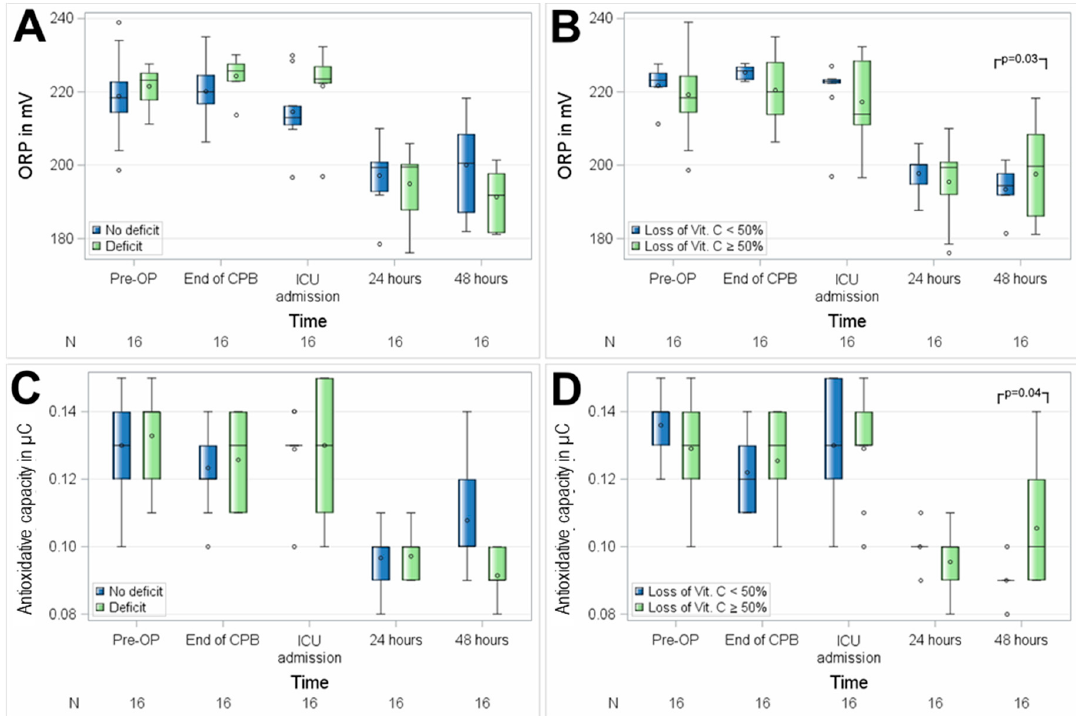
Figure 6. Association of perioperative vitamin C levels with oxidative stress, assessed as oxidation–reduction potential (ORP) ( A , B ) and anti-oxidative capacity ( C , D ). N, number of patients; ( A , C ), patients with preoperative vitamin C deficit; ( B , D ), patients with intraoperative loss of vitamin C ≥ 50%. Circles represent outliers.